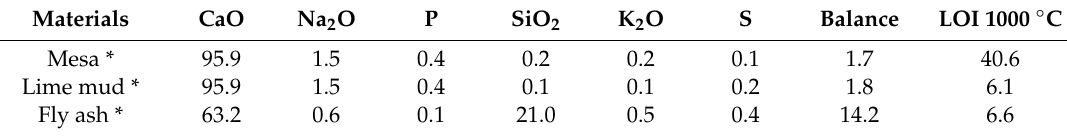
Table 1. Contentsofmaincomponents(inwt%)oflimerichwastematerialsusedinmetallurgicalbriquettes. Materials CaO Na 2 O P SiO 2 K 2 O S Balance LOI 1000 ◦ C Mesa *